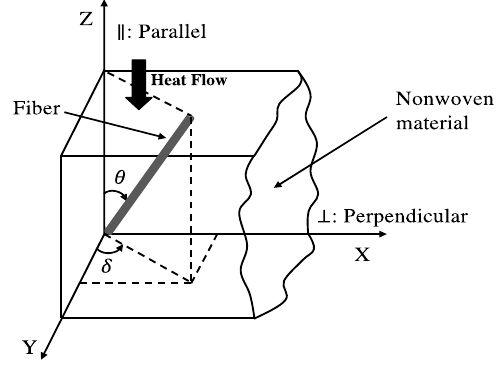
Figure 2. Fiber orientation angle in three-dimensional nonwoven fibrous material.